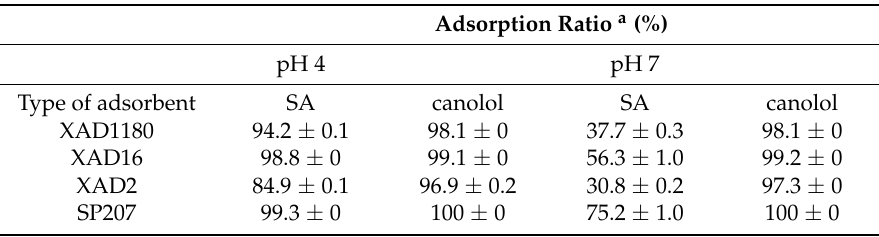
Table 1. Adsorption of SA and canolol for the different resins tested.